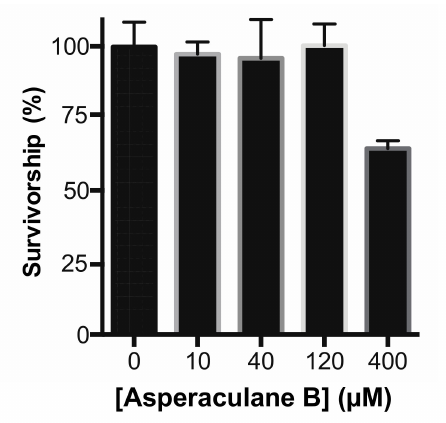
Figure 8. Cytotoxicity of asperaculane B at the varying concentrations (0-400 µ M) on the human kidney cell line (HEK293).